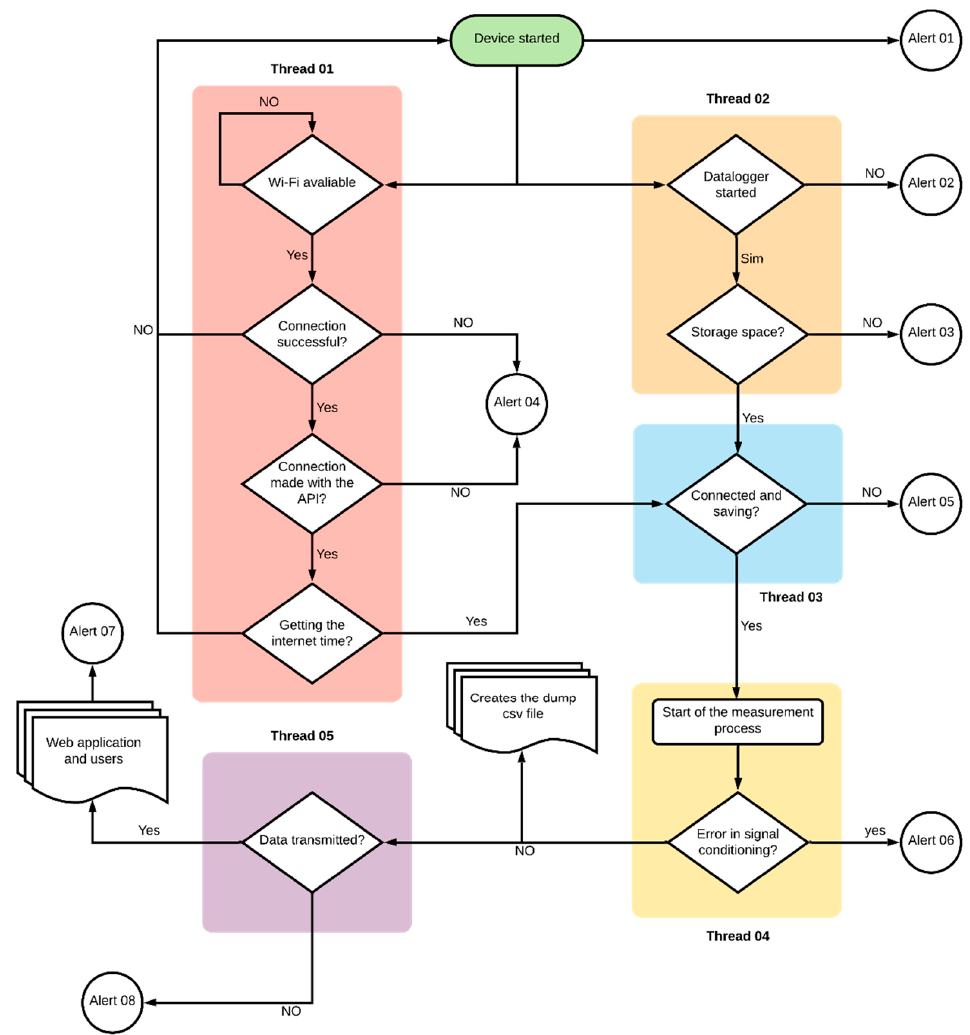
Figure 7. Flowchart of the identification of the firmware blocks and